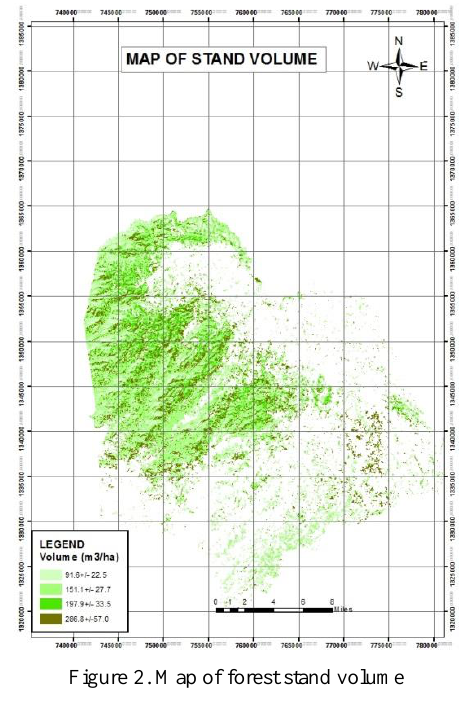
Figure 2. Map of forest stand